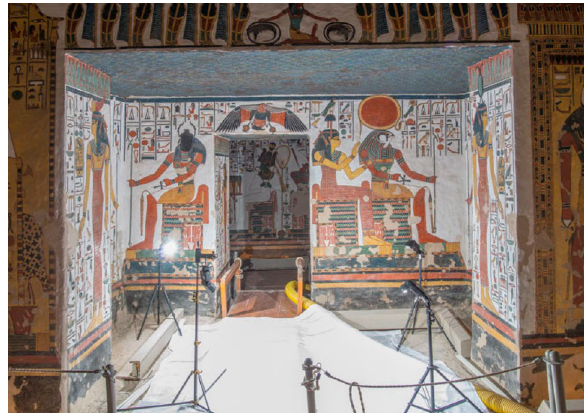
Figure 3. Speedlights and a white sheet were used to reflect light onto the paintings for even lighting during the 2017 survey of the Tomb of Nefertari (Credit: Carleton Immersive Media Studio; Carleton University. © J. Paul Getty Trust).